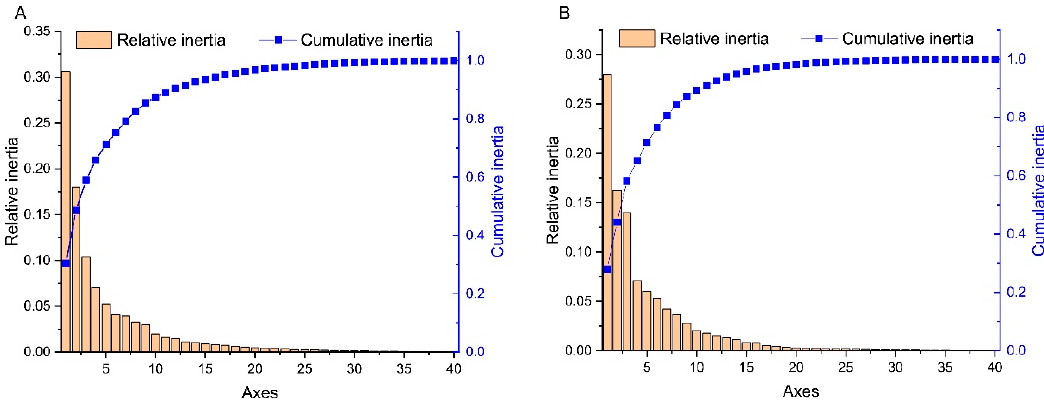
Figure 2. The relative and cumulative inertia of the 40 axes from a PCA of the RSCU values based on the CP ( A ) and NABP ( B ) genes of PVM.